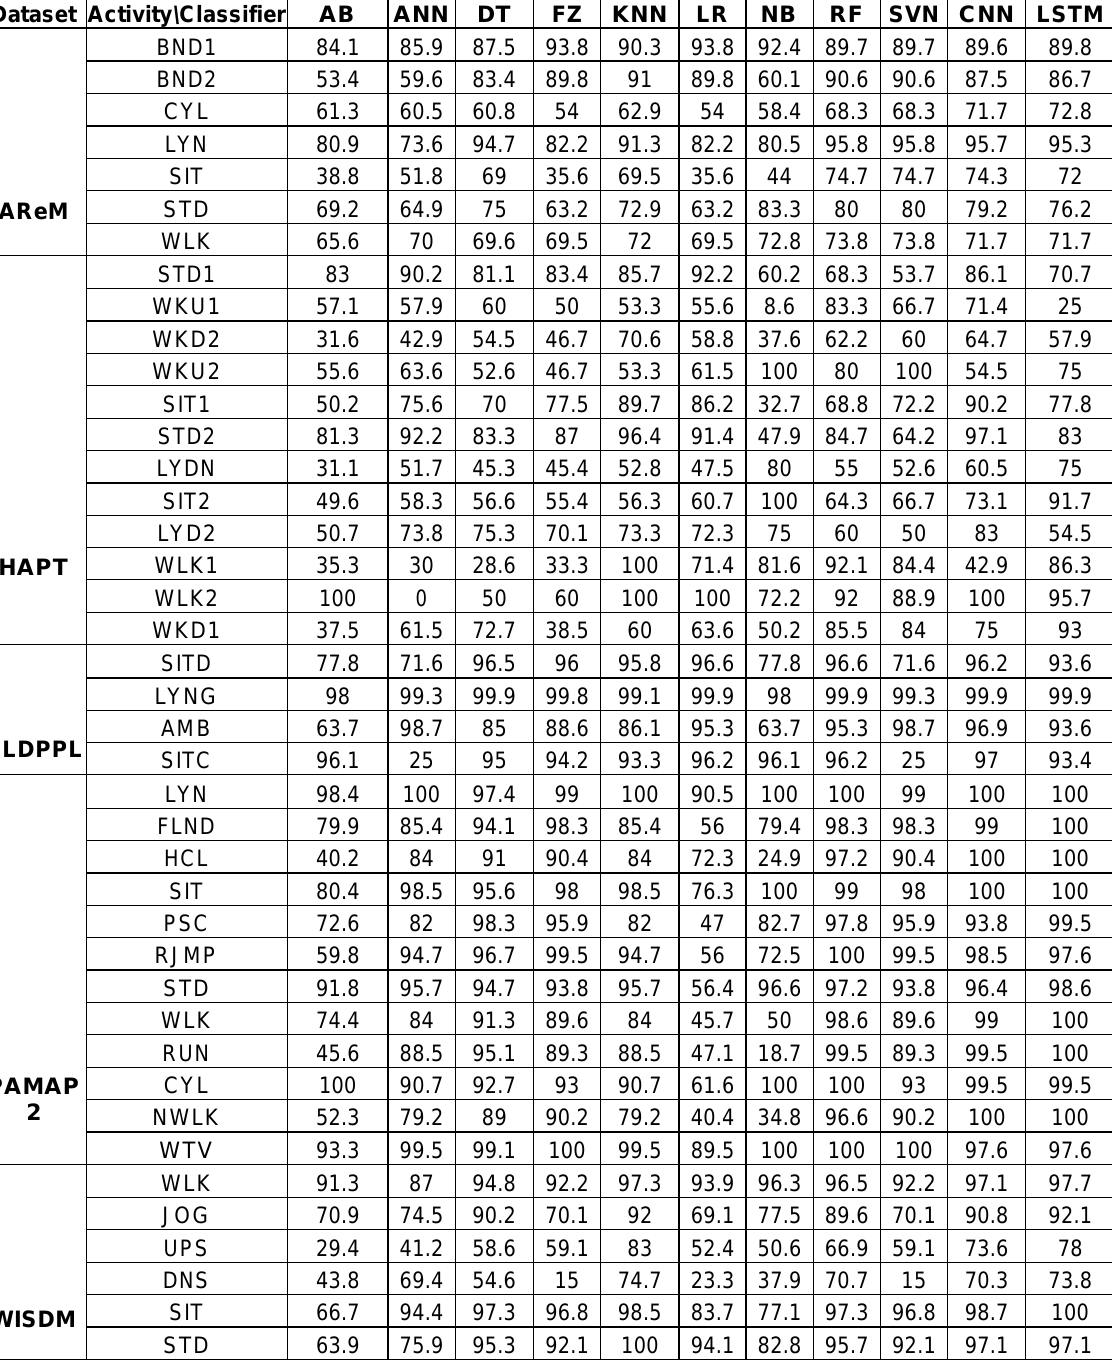
Dataset Activity \